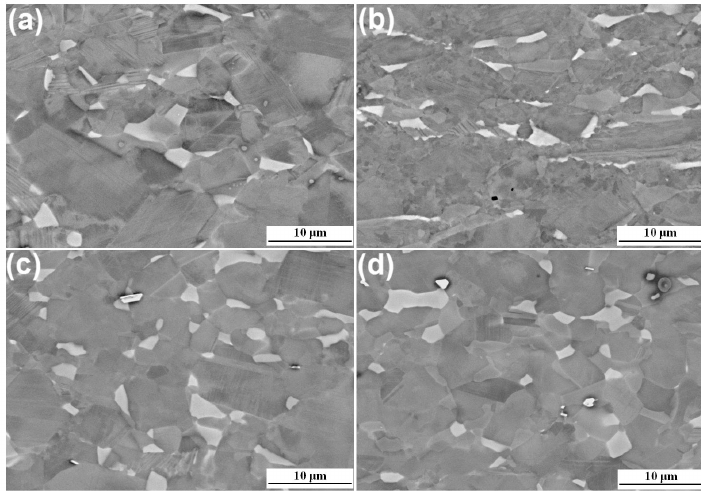
Figure 6. SEM images in BSE mode of the alloy after compression deformation under 1000 °C/10 − 2 s − 1 / ε = 0.11 ( a ), 1000 °C/10 − 2 s − 1 / ε = 0.36 ( b ), 1000 °C/10 − 4 s − 1 / ε = 0.11 ( c ) and 1000 °C/10 − 4 s − 1 / ε = 0.36 ( d ).